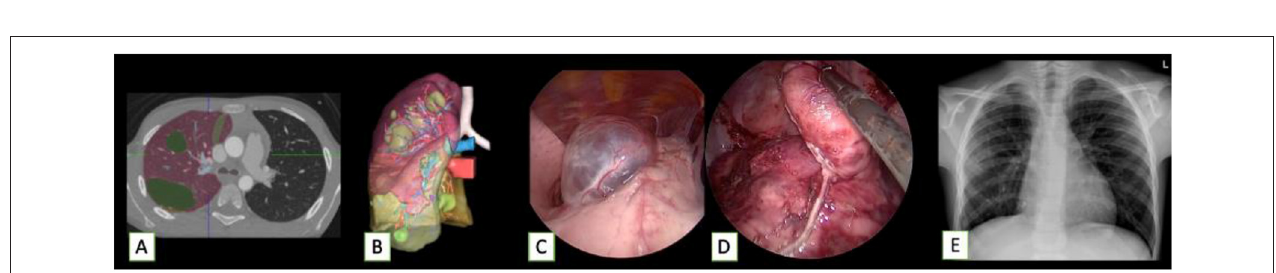
FIGURE 1 | Thymoma excision in an 11-year-old girl: (A) MRI pre-operative imaging. (B) Identification and preservation of the phrenic nerve. (C) Dissection of the thymus from the pericardium.